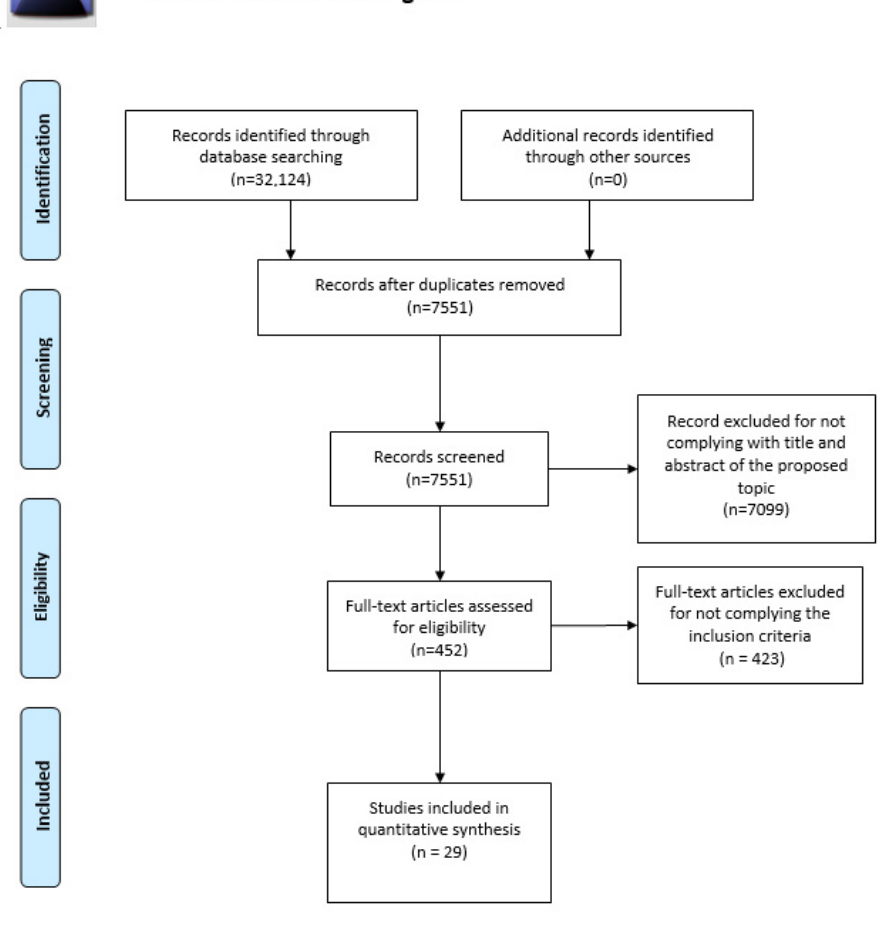
Figure 1. PRISMA Flow Diagram adapted with permission from The PRISMA group, 2020 [10].